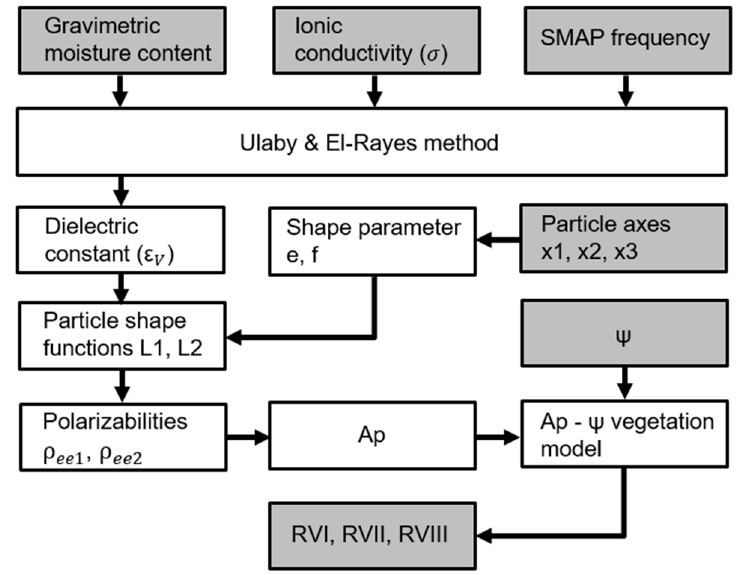
Figure 3. Conceptual workflow of the model-based RVI, starting at permittivity input level. Input and output parameters are marked in grey boxes.